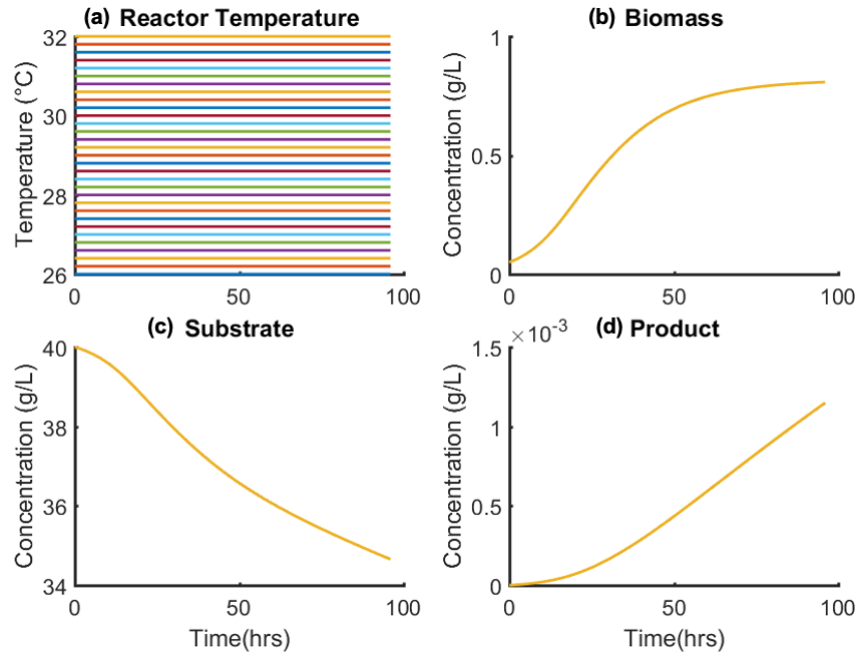
Figure 8. Effect of varying T ( t ) = constant ( a ) on ( b ) biomass, ( c ) substrate, and ( d ) product concentrations.